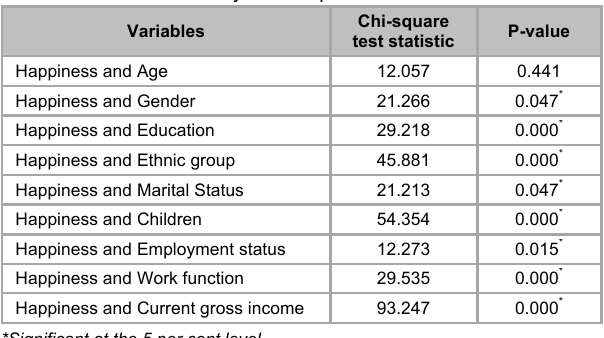
Summary of chi-square